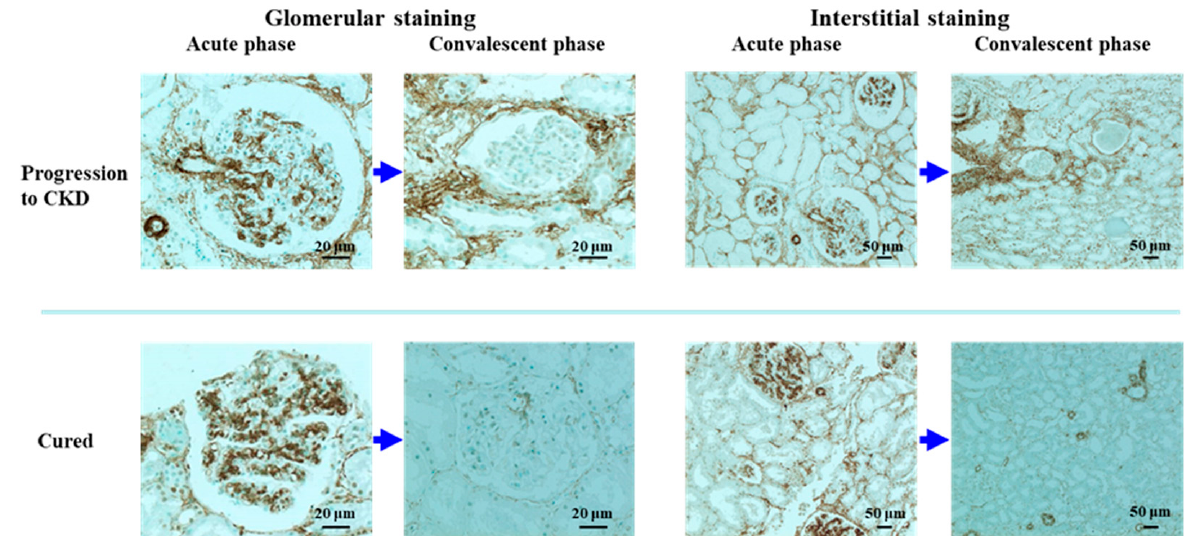
Figure 4. Immunoperoxidase staining for alpha-smooth muscle actin ( α -SMA) with methyl green counterstaining in repeated renal biopsy sections from the acute phase and the convalescent phase of a PSAGN patient who developed chronic kidney disease (CKD), and a PSAGN patient who was cured. Strong positive staining of α -SMA in the mesangial area of the glomeruli was observed in tissues of PSAGN patients in the acute phase irrespective of disease prognosis, and this glomerular staining diminished uniformly in the convalescent phase irrespective of disease prognosis. Interstitial α -SMA staining was more intense in the PSAGN patient who developed CKD than in the patient who was cured, both in the